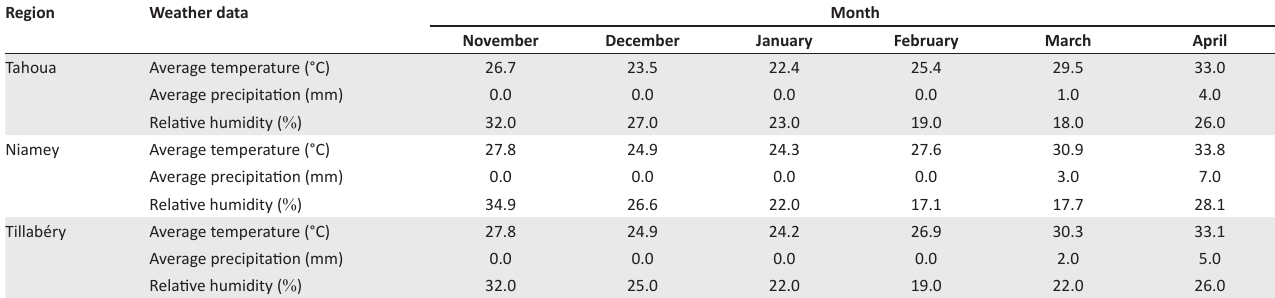
TABLE 1: Weather data for the study area. Region Weather